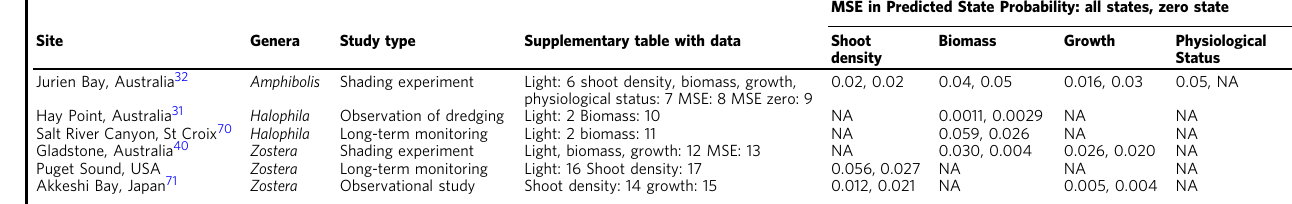
Table 1 Mean-squared error in predicted-state probability for all states and the zero state